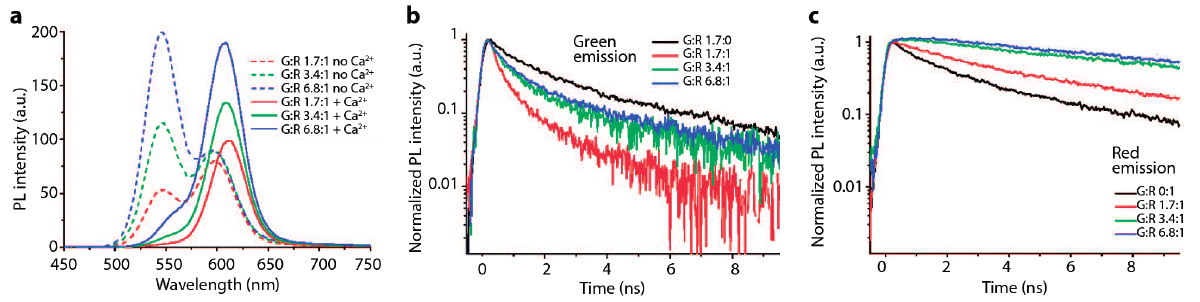
Figure 16. Impact of excess donor on spectral results and time-resolved PL. ( a ) Steady-state PL spectra of mixed green and red, donor and acceptor CdTe QDs with three different donor: acceptor ratios. Spectra shown are for QDs mixed in the absence of Ca 2+ and QDs mixed in the presence of Ca 2+ , which caused the QDs to associate with each other in close enough proximity to induce FRET; ( b , c ) Time-resolved PL decay curved of donor green ( b ) and acceptor red ( c ) QDs in pure green or red samples and in mixed samples in the presence of Ca 2+ . Reprinted with permission from [76]. Copyright (2008) American Chemical